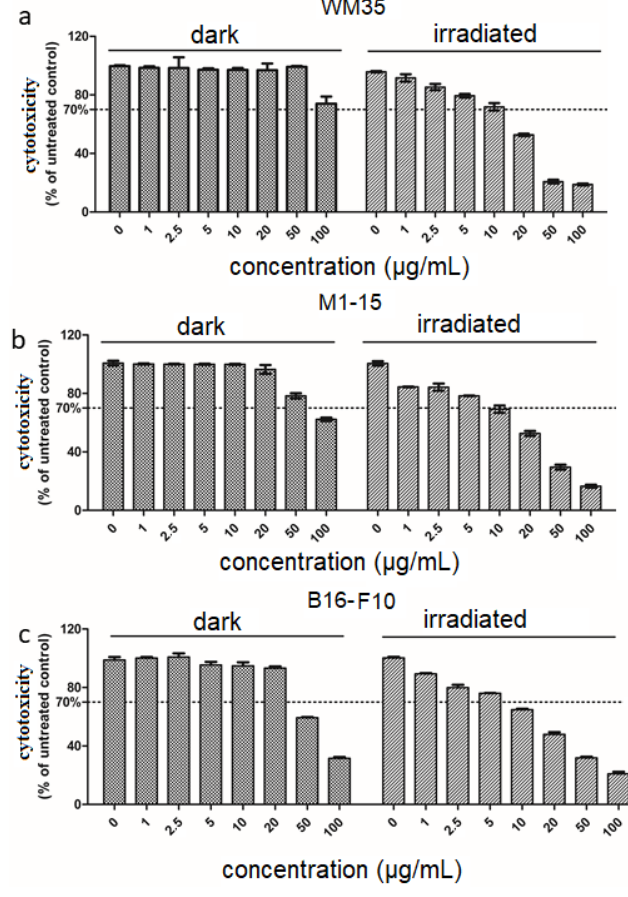
Figure 1. Cytotoxicity assessment. Comparative cytotoxicity testing w/wo irradiation 100 mJ/cm 2 of WM35 ( a ), M1-15 ( b ), and B16-F10 ( c ) co-cultures exposed to THPP (concentration range 2.5–100 µg/mL). Viability is expressed as % of untreated controls (mean ± SD, n = 3), toxicity limit is drawn at 70% of untreated control (right panels).